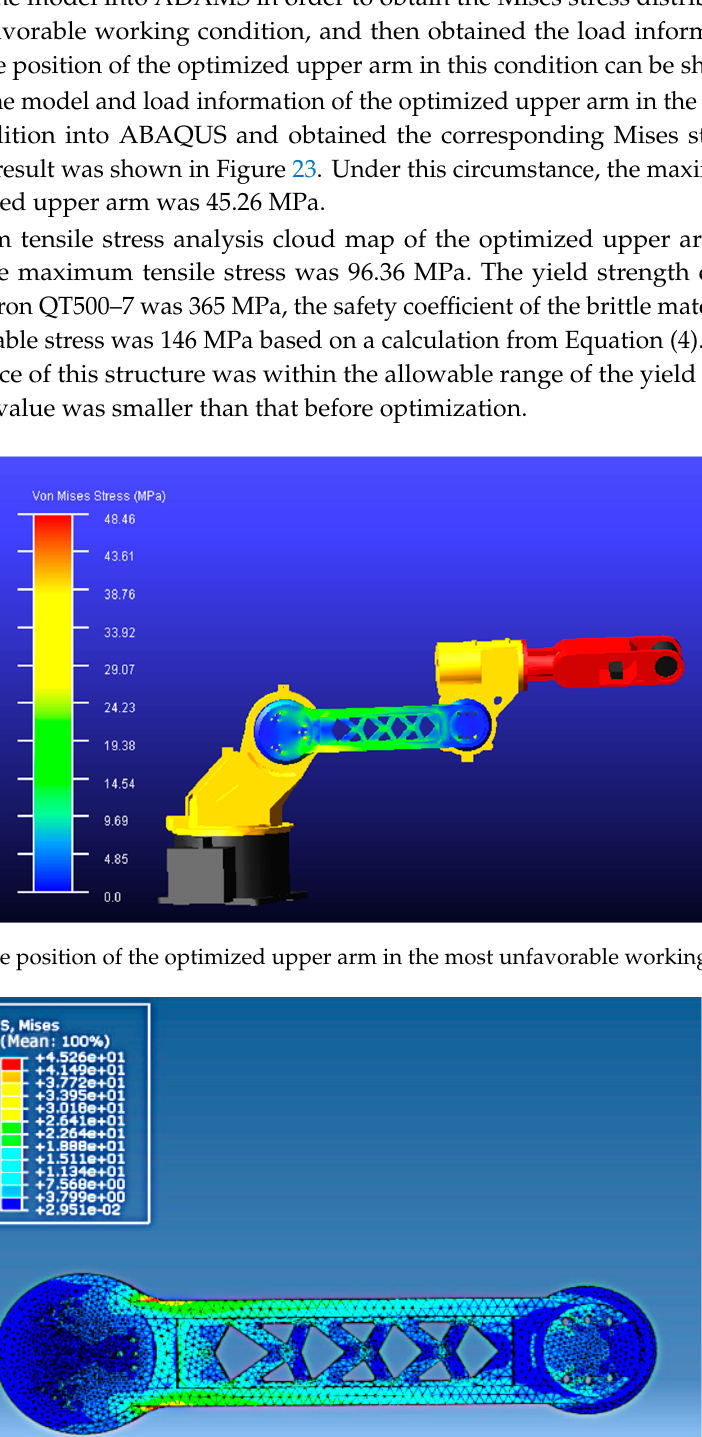
Figure 21. Comparison of the upper arm between before and after optimizations: ( a ) before optimization and ( b ) after optimization.